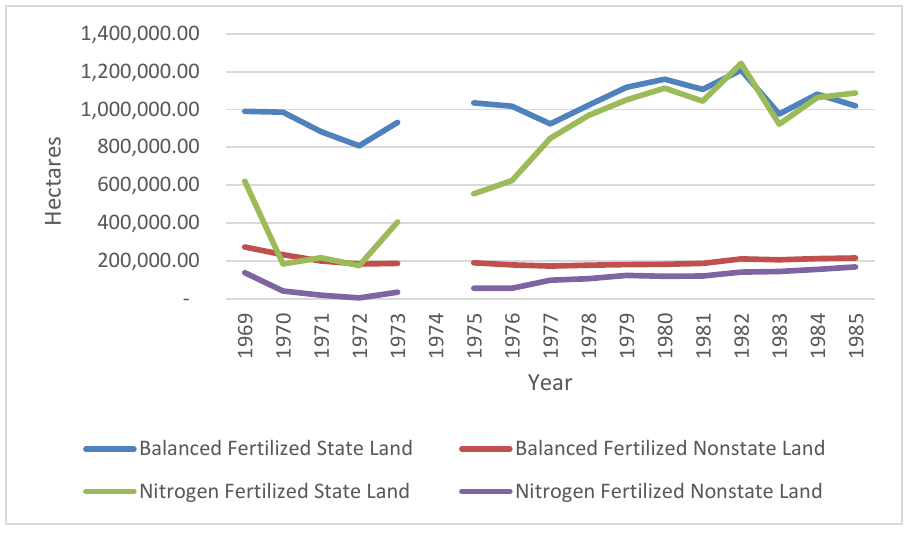
Figure 1. Fertilizer Application on State and Nonstate Land in Sugar,